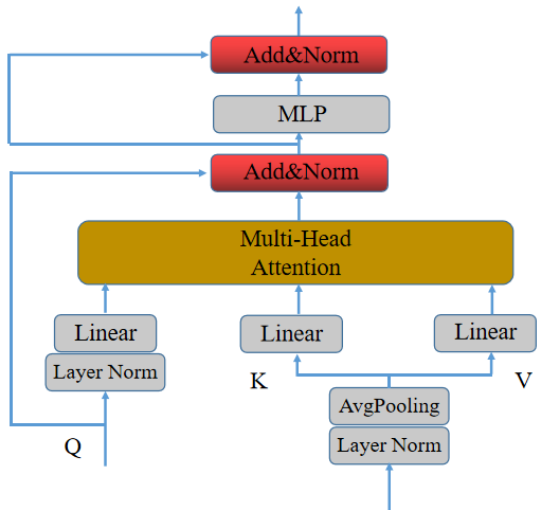
Figure 2. Schematic diagram of the proposed TFE block. The module consists of three parts: Multi- Head Attention, Layer Norm and MLP.